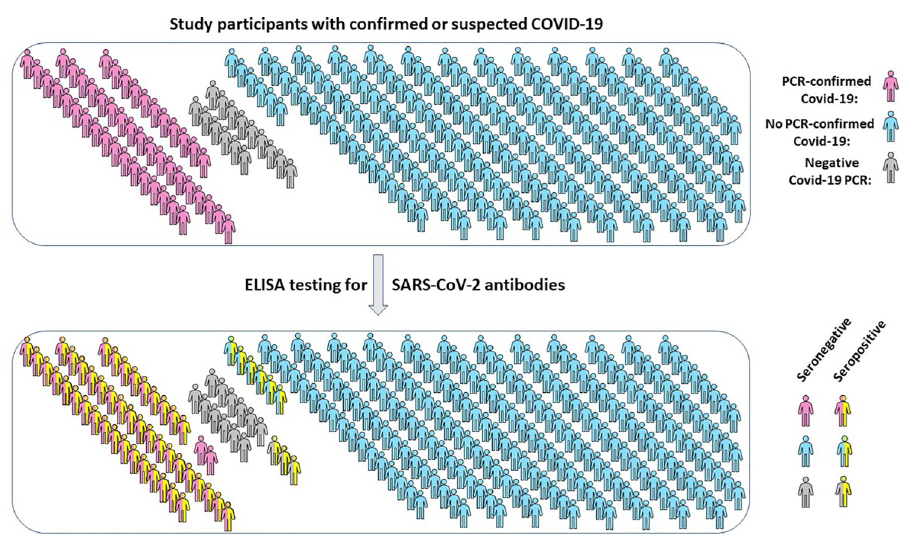
Fig 3. Distribution of study subjects with confirmed or suspected COVID-19. Of 263 individuals recruited, 46 had previous SARS-CoV-2 infection confirmed by PCR testing. All were subsequently tested by ELISA for antibodies against SARS-CoV-2 S and N proteins with results summarized as